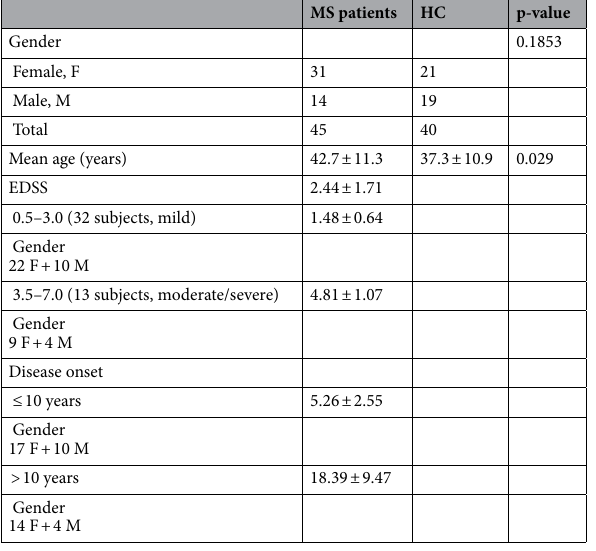
Table 1. Demographic data and clinical variable of the MS patients. Values are quoted as average ± standard